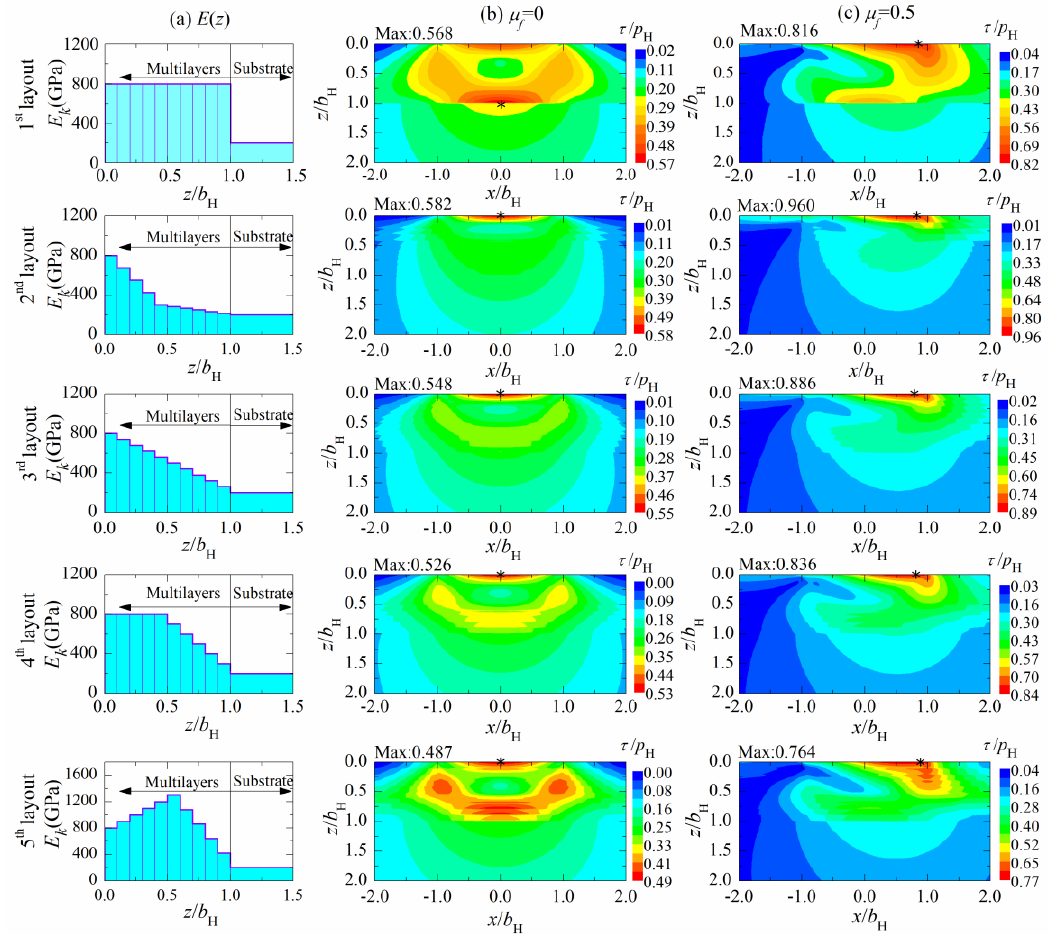
Figure 5. Contour plots of the maximum shear stress in the subsurface of multilayered solids with various structure layouts of multilayers, ( a ) the structure layouts of multilayers, ( b ) the contour plots of the maximum shear stress when μ f = 0, ( c ) the maximum shear stress when μ f = 0.5.